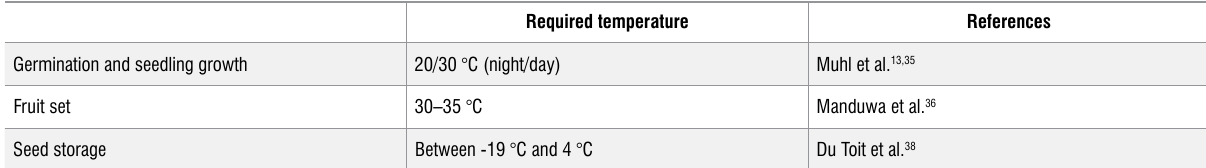
Temperature requirements proposed by various studies conducted within South Africa for growth and development stages and storage of moringa